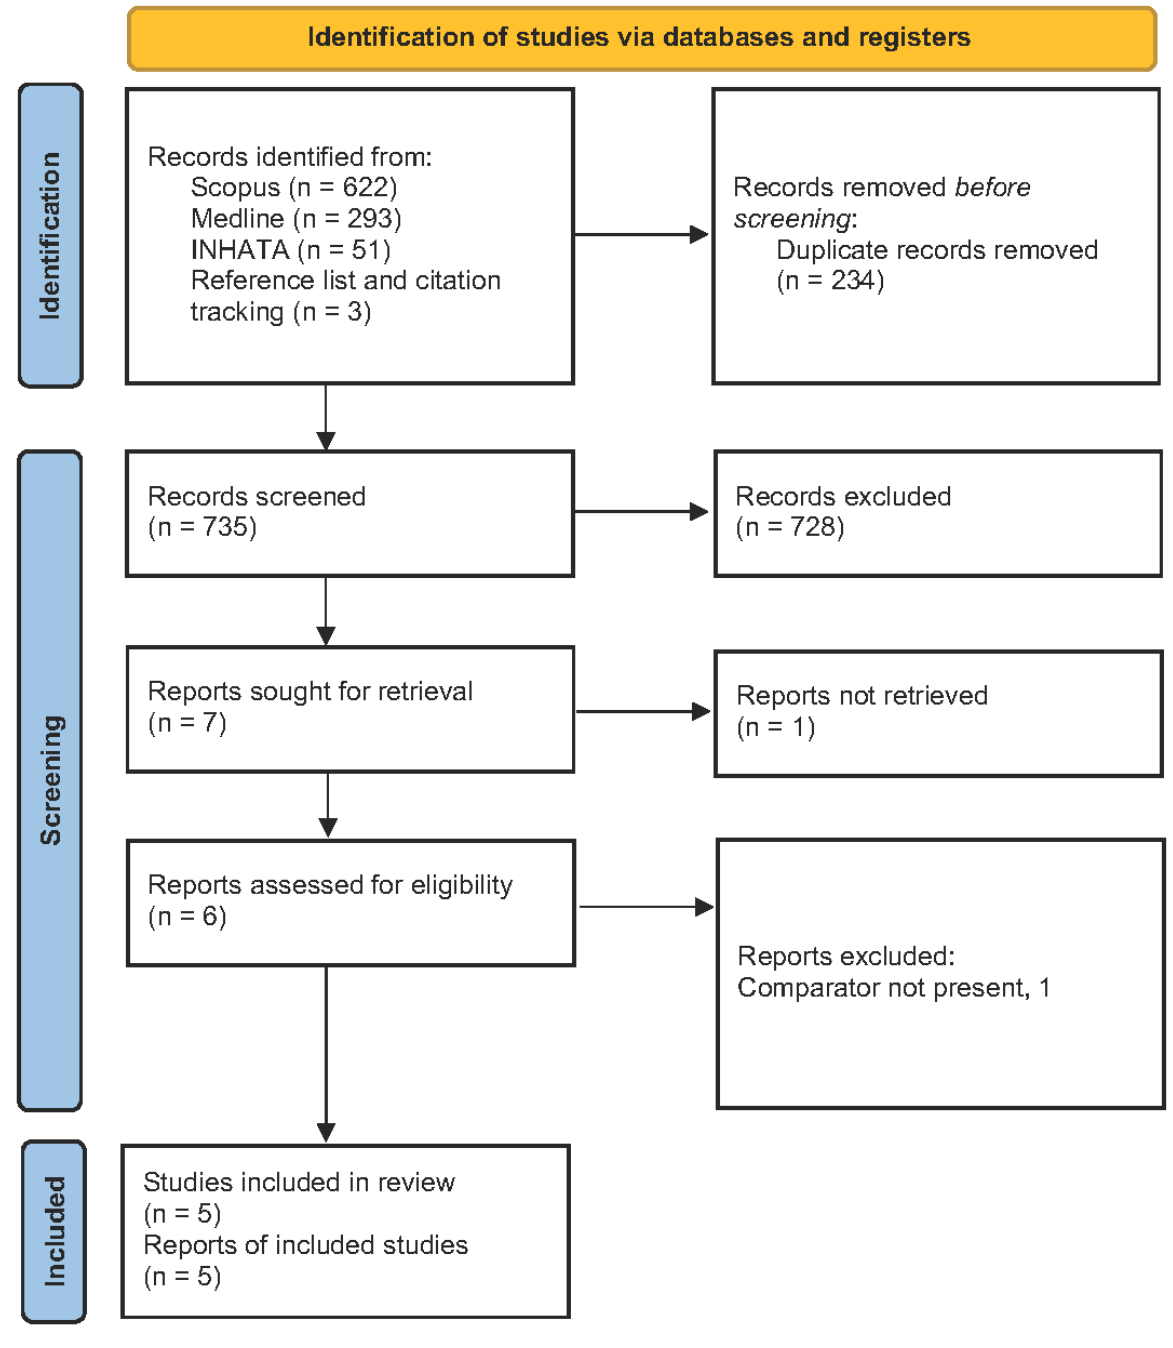
Figure 1. PRISMA 2020 flow diagram [11].